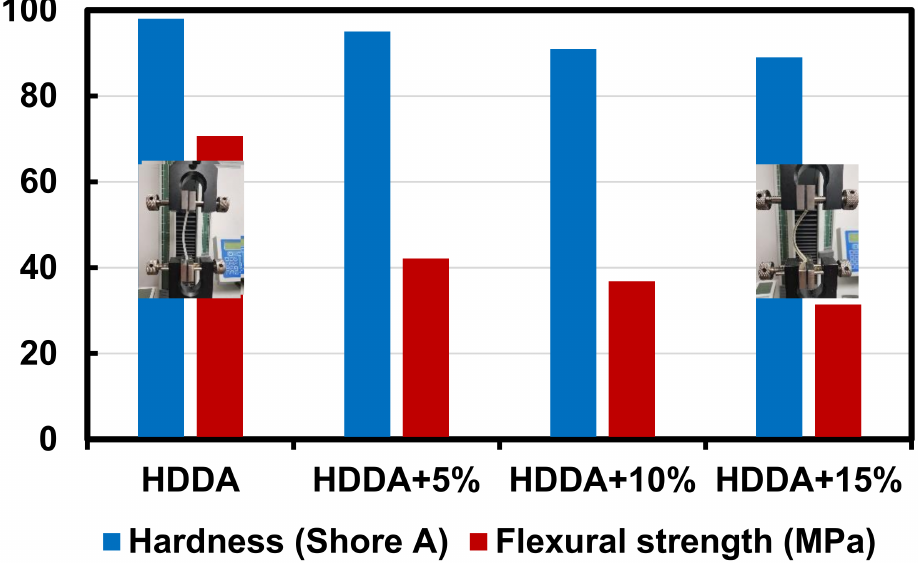
Figure 3. Comparison of the hardness and flexural strength of rectangular 3D elastomers printed based on a PA-APU resin as a function of the APU